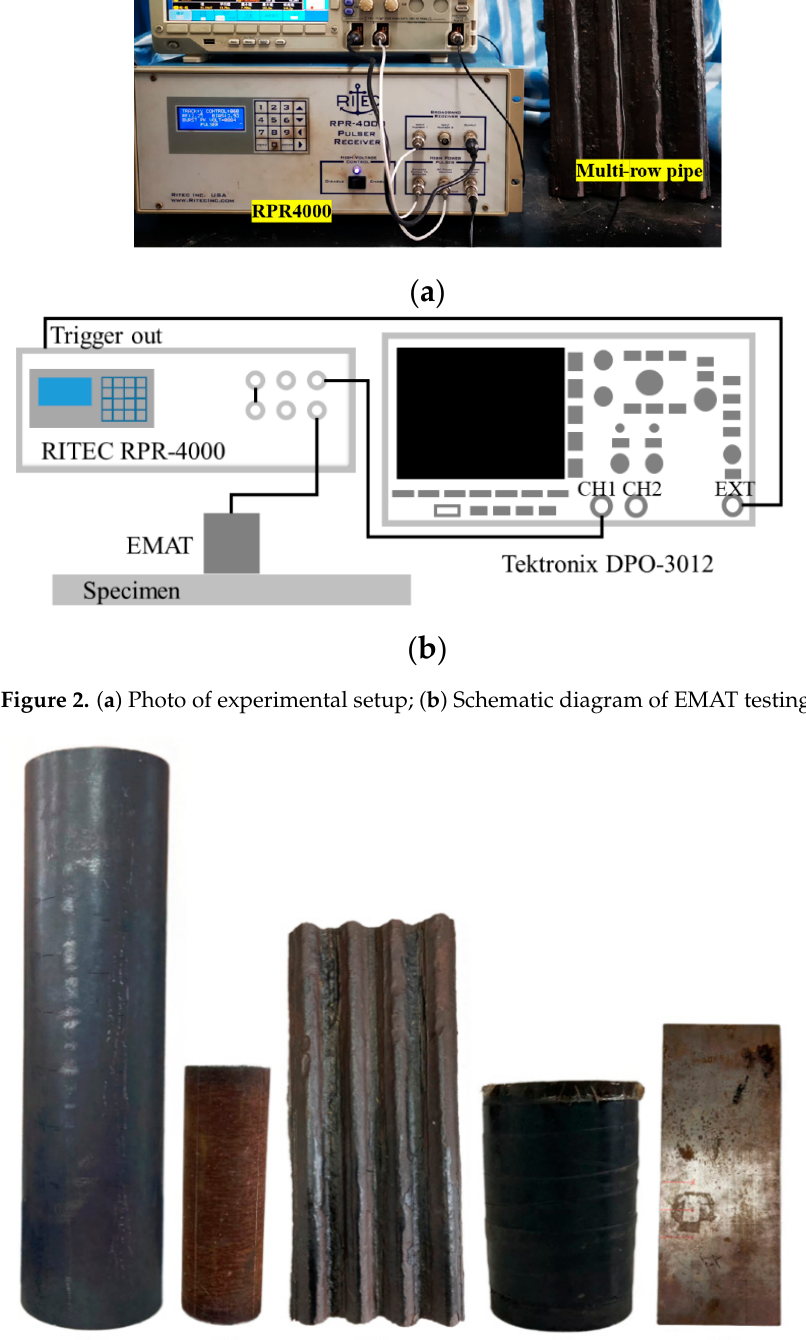
Figure 3. Schematic diagram of EMAT testing system. 3.1. Comparison Experiments for Different Specimens First, the experiments were conducted on all five specimens; the original signals col- lected are shown in Figure 4 which demonstrates that, except for steel plate #3, the signal-